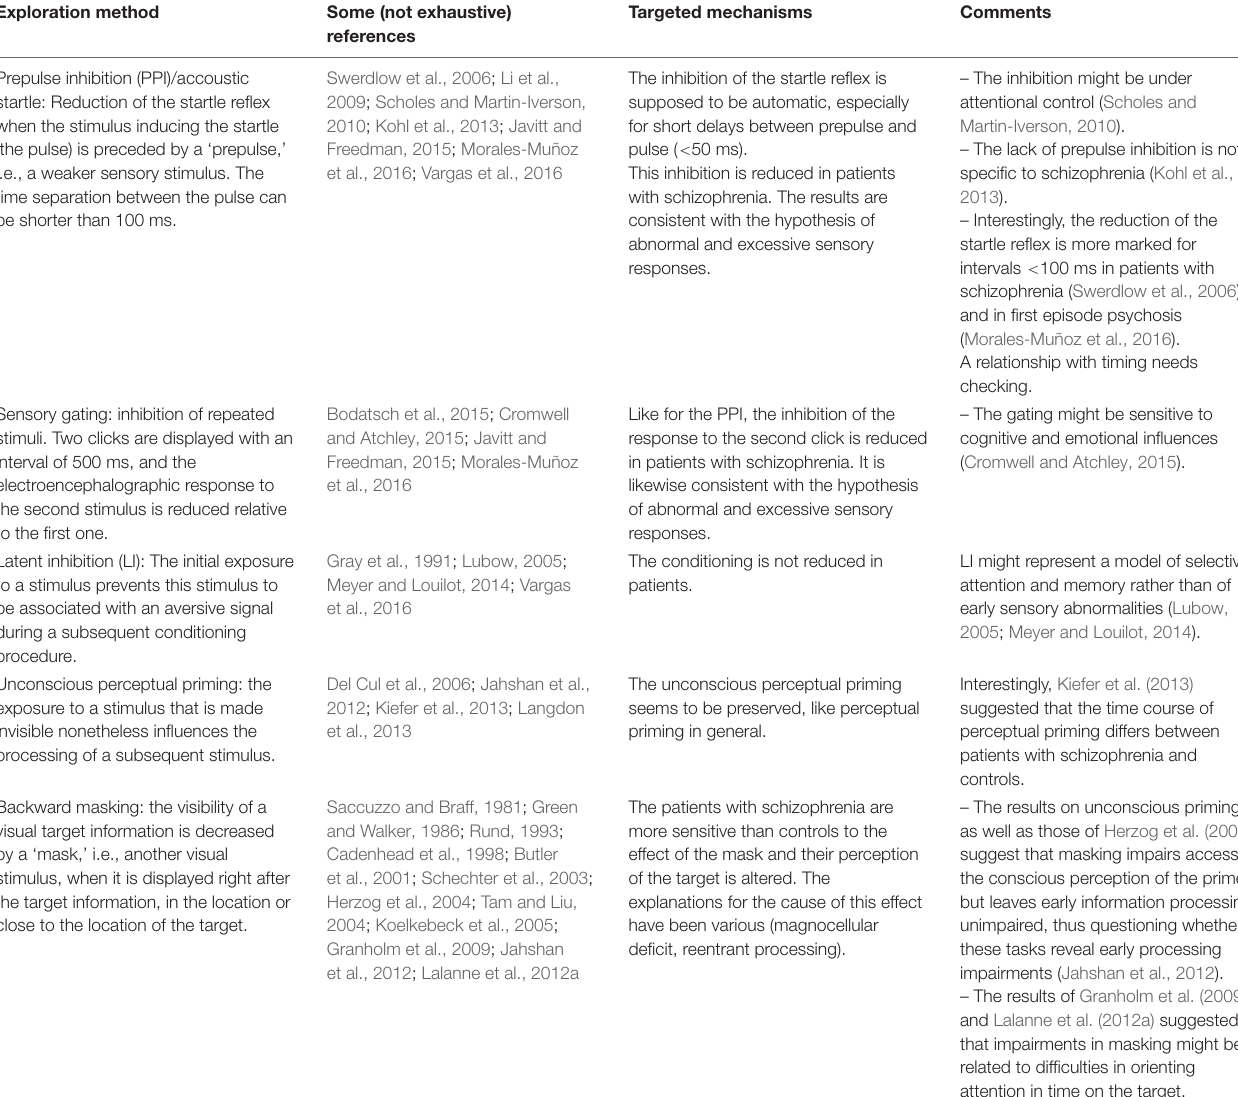
TABLE 1 | List of some lines of research aimed at testing early sensory processing